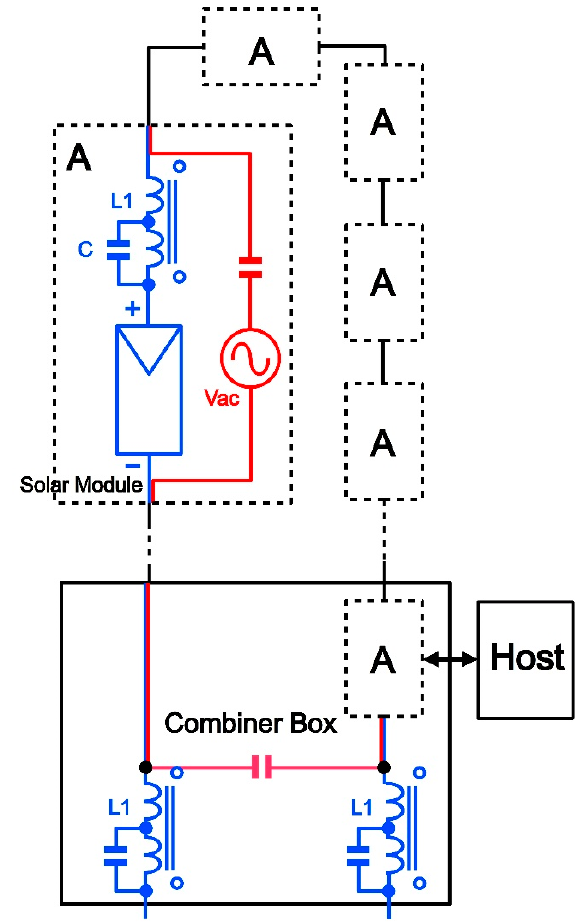
Figure 2. General setup for field measurements.